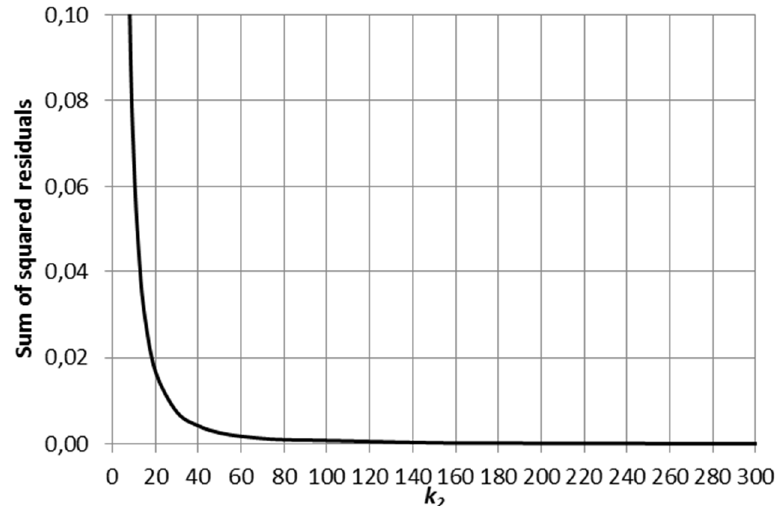
Figure 4. Sum of squared residuals as a function of the rate parameter k 2 of the rapid reaction step 2 in the general case of consecutive reaction system compared to the special case ( k 1 = 1, K 1 = 10 and K 2 = 10).